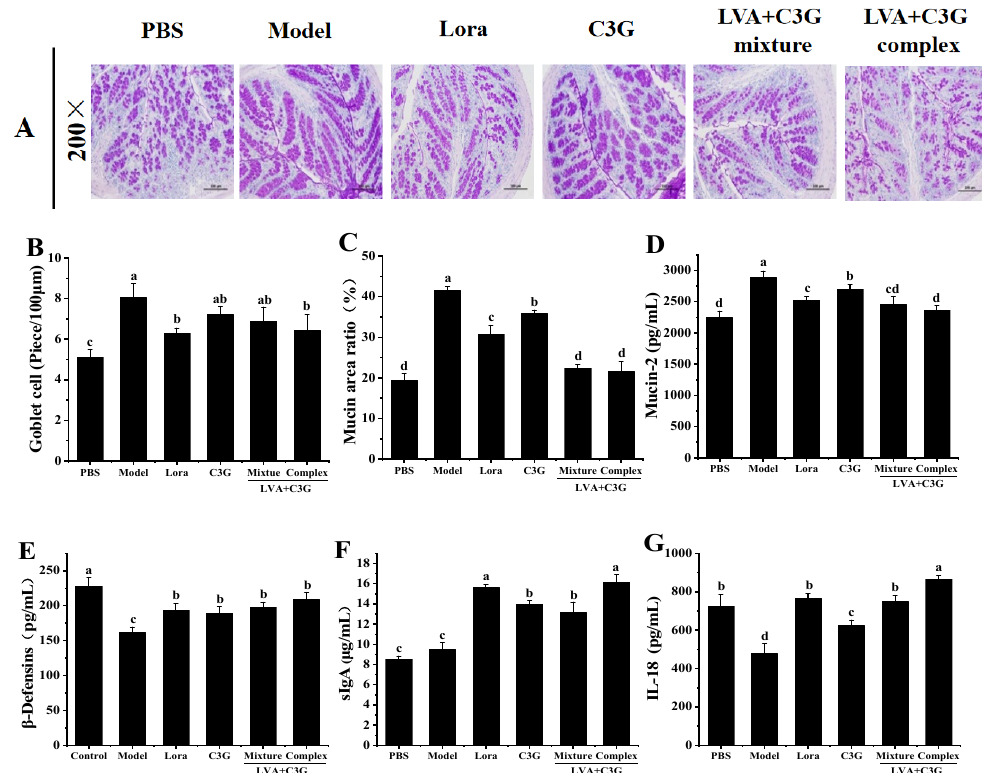
Figure 4. The effect of the C3G-associated samples on the chemical barrier function of the intestinal epithelium. ( A ) Photomicrographs of a PAS-stained colon section. ( B ) Goblet cells per unit length (100 µ m). ( C ) The mucin area ratio of the mucus layer. ( D ) The mucin-2 levels in the mucus layer. ( E , F ) The β -defensin and sIgA levels in the mucus layer. ( G ) The intestinal IL-18 levels. Significant differences ( p < 0.05) are identified by different letters.